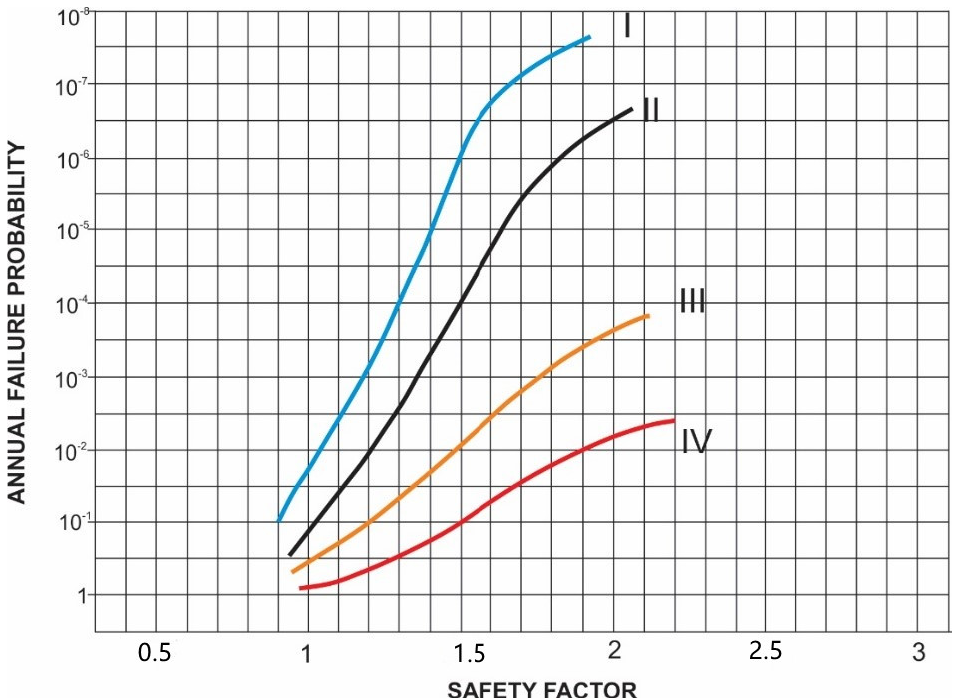
Figure 3. The method for the evaluation of annual failure probability [24]. Reproduced with permission from publisher Journal of Geotechnical and Geoenvironmental Engineering, F. Silva, T. W. Lambe, W. A. Marr, Probability and risk of slope failure . Journal of Geotechnical and